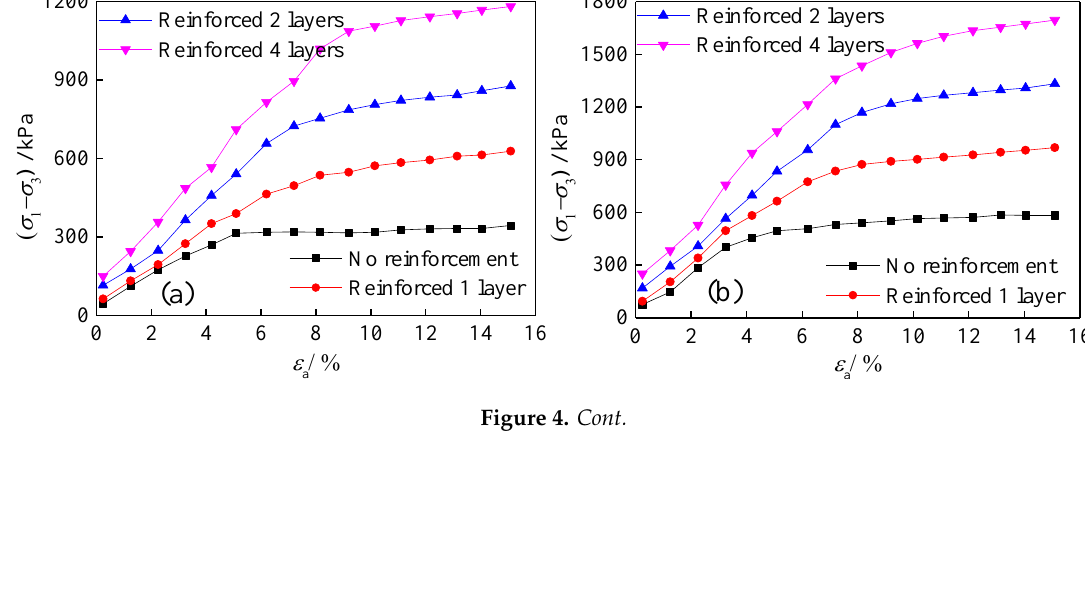
Table 2. Reinforced materials for the